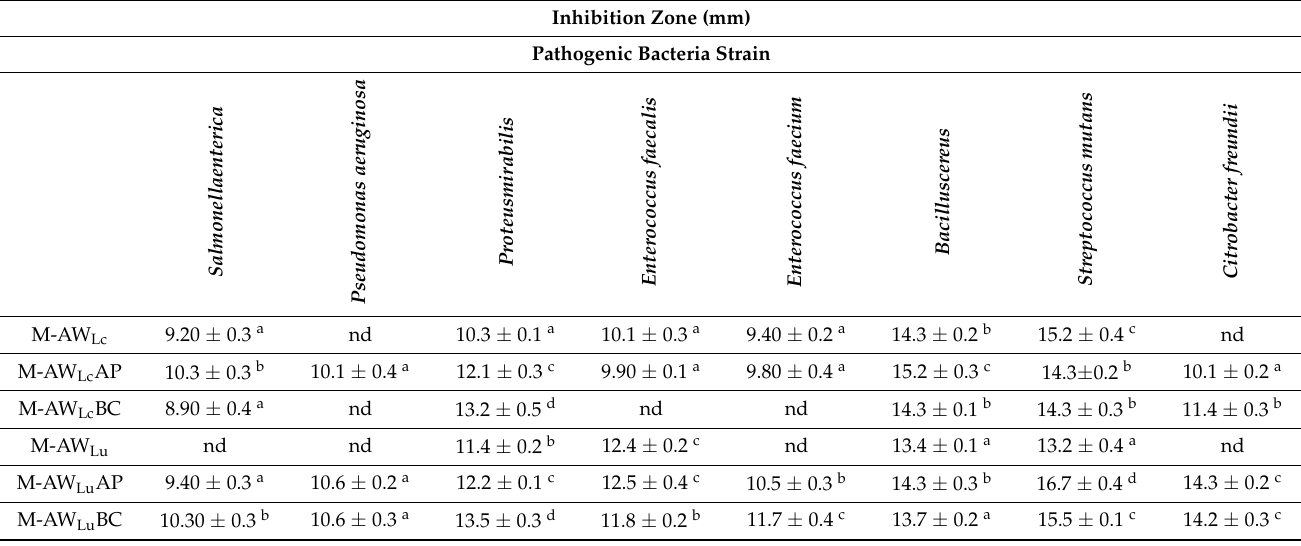
Table 4. The antimicrobial activity of the prepared